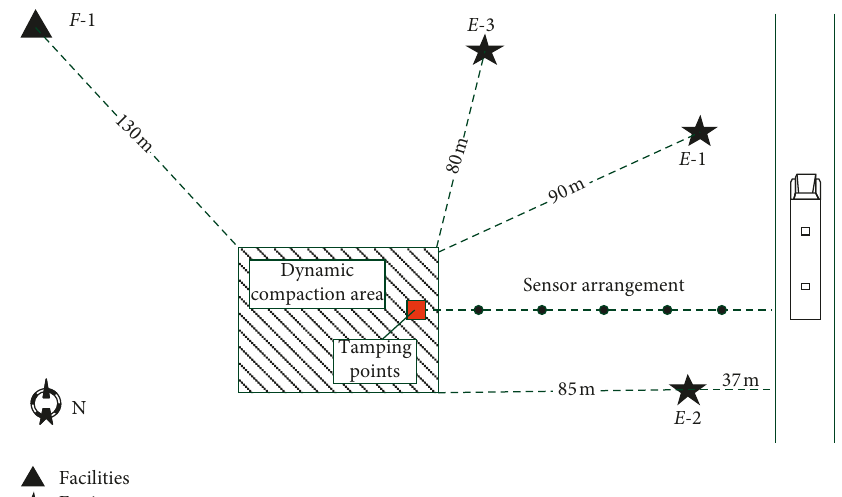
Figure 1: Layout of the plant and the arrangement of velocity sensors in the tested area.